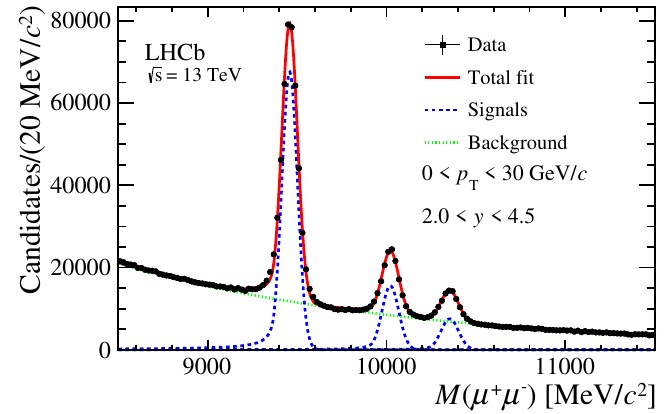
Figure 1 . Dimuon invariant mass distribution of (cid:7) candidates with 0 < p T < 30 GeV =c and 2 : 0 < y < 4 : 5. The (cid:12)t result with the Crystal Ball functions plus an exponential function is also shown. The black dots refer to the data, the blue dashed line refers to the three signals and the green dotted line refers to the